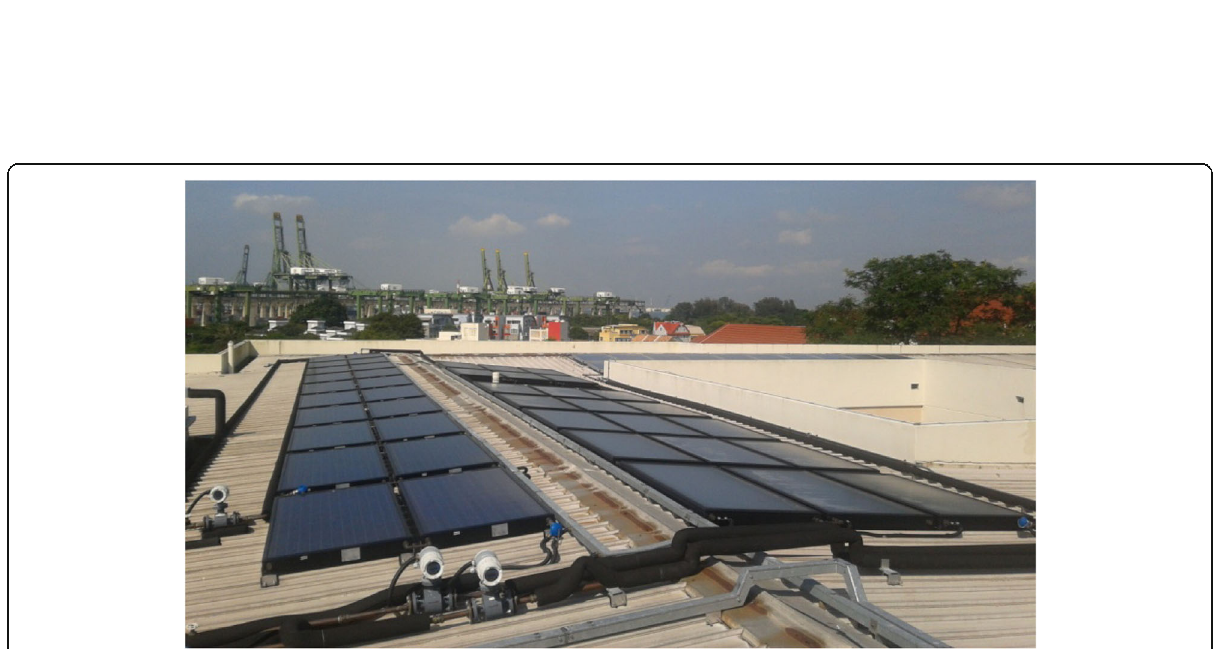
Fig. 2 Photograph of installed PVT modules in the hostel roof